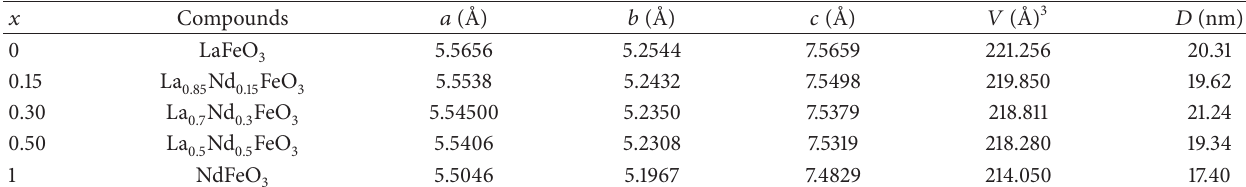
Table 1: The cell parameters and crystallite sizes of La 1−𝑥 Nd 𝑥 FeO 3 powders.